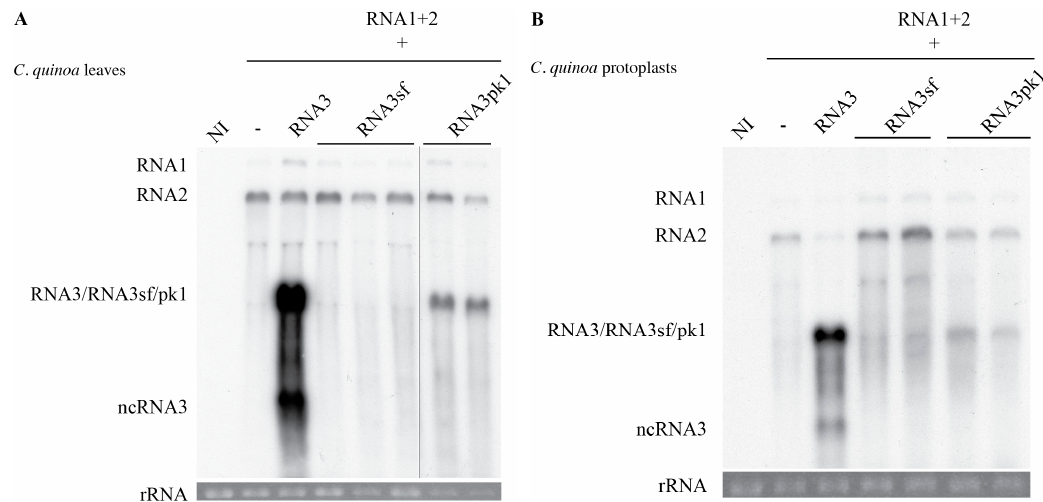
Figure 7. The BNYVV replication machinery does not replicate RNA3sf and poorly replicates RNA3pk1. Chenopodium quinoa leaves were rub-inoculated ( A ) or protoplasts electroporated ( B ) with RNA1+2 alone (-) or supplemented with RNA3, RNA3sf, or RNA3pk1. ( A ) RNA contents of local lesions were analyzed 7 days post-inoculation (dpi) by northern blot using BNYVV-RNA-specific radiolabeled probes. RNA3pk1 loading was three times lower than the other samples; the membrane was exposed accordingly and visualized with a split line. ( B ) Protoplasts contents were analyzed 40 h post-inoculation (hpi) as for ( A ). Loadings are visualized by ethidium-bromide staining of total RNAs (rRNA). NI, non-infected.